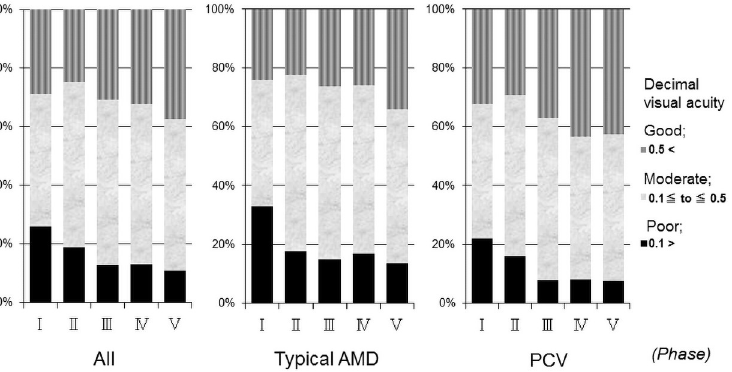
Fig 3. Changes of the distribution in decimal visual acuity (VA) in the 1,777 eyes. The proportion of good baseline VAs increased significantly ( P < 0.05, chi-square test) in phase V (37.4%) compared with phase I (29.1%). The prevalence rates of poor baseline VA in phases I, II, III, IV, and V were 26.0%, 18.8%, 13.0%, 13.0% and 11.0%, respectively, which differed significantly ( P < 0.0001, for all comparisons chi-square test) in phases III, IV, and V compared with phase I. Phases I, II, III, IV, and V spanned, respectively, March 2003 to February 2005, March 2005 to February 2007, March 2007 to February 2009, March 2009 to February 2011 and March 2011 to February 2013. PCV = polypoidal choroidal vasculopathy; AMD = age-related macular degeneration.